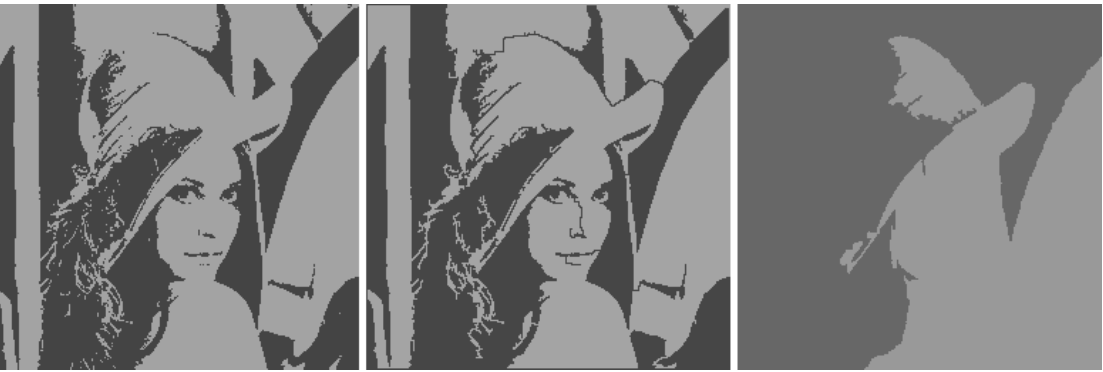
Figure 1. Optimal (on the left), really optimized two-segment approximation (central), and iteratively segmented (on the right) image approximation with the standard deviations σ =30.64564, σ = 31.60341 and σ = 50.33156.